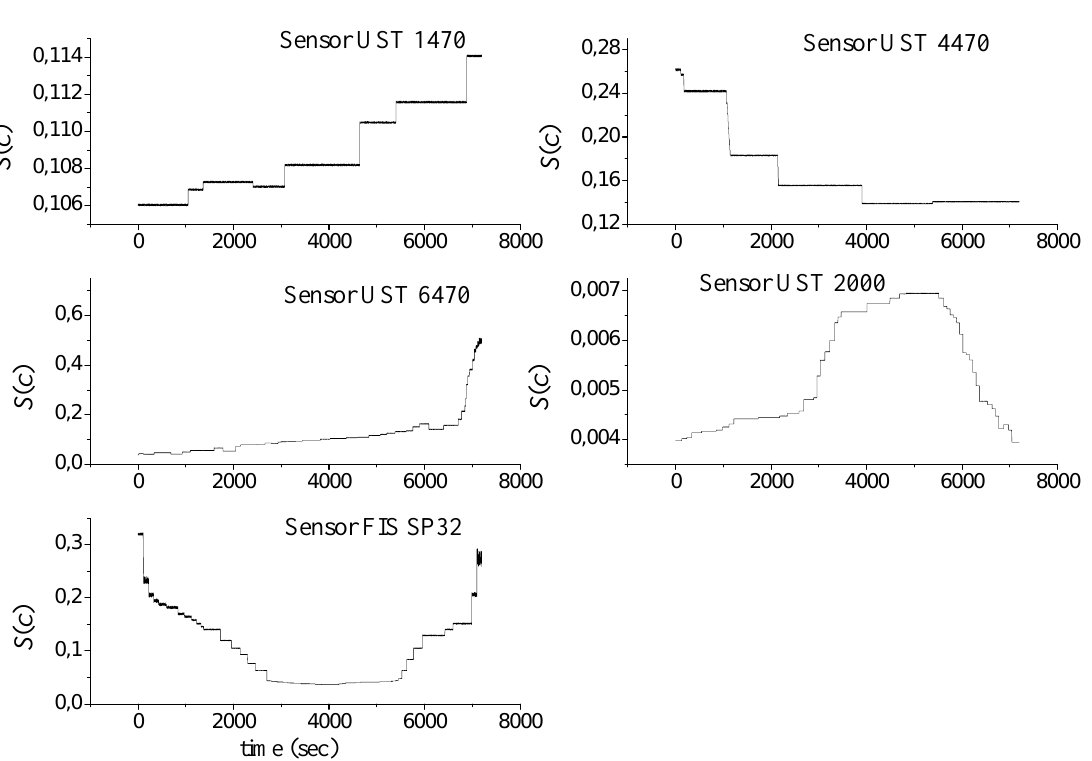
Figure 5. Simulated input signal profiles of the five gas sensor array. These signals are used to calculate the main gas concentrations. The cross-sensitivities are gas concentrations from the previous iteration step.